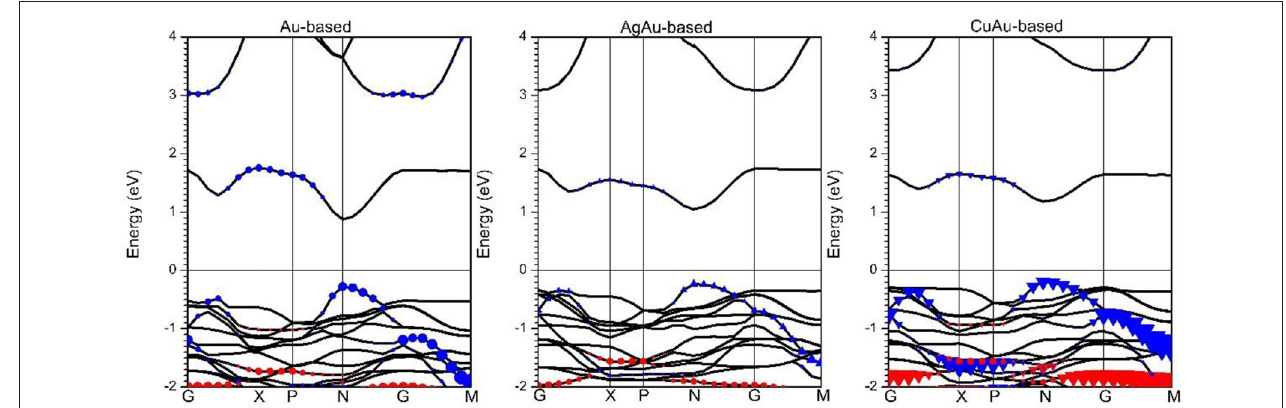
FIGURE 2 | The HSE band structures of 1B-based perovskite solar cell absorbers. Blue and red shapes indicate the d z 2 and d x 2 -y 2 orbitals of 1B atoms, respectively. Circles, triangles, and inverted triangles represent Au, Ag, and Cu atoms contributions, respectively.